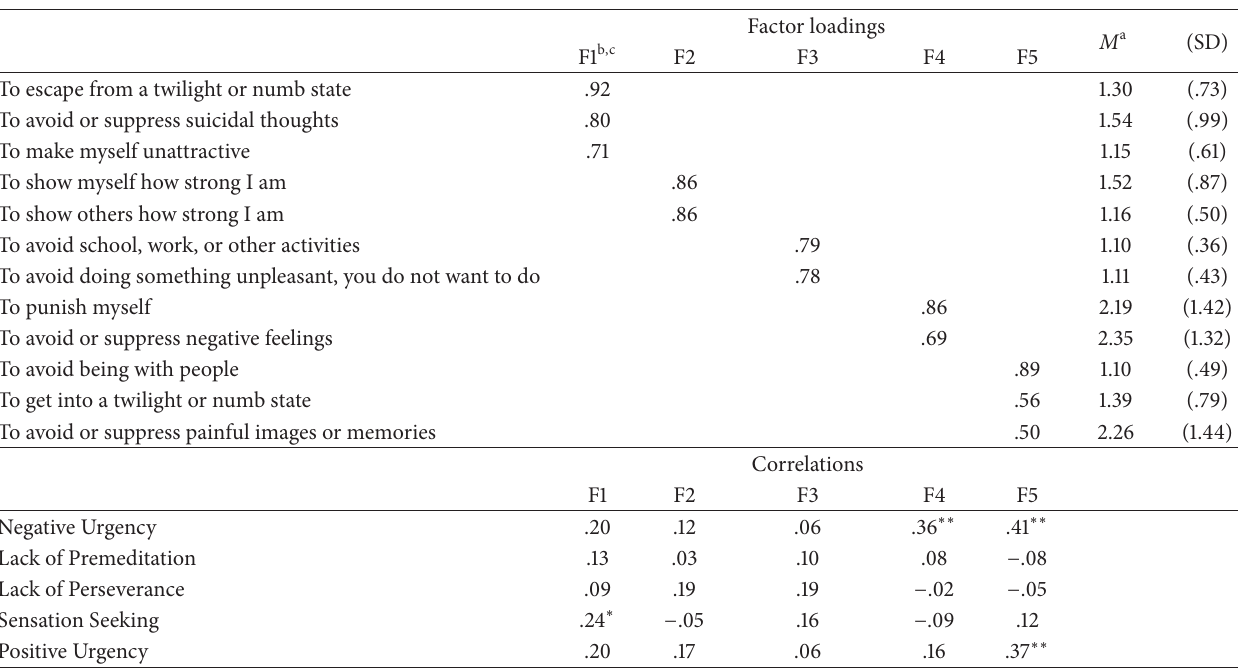
Table 2: The factor loadings, means, and standard deviations of the NSSI functions, and the relationship between the NSSI function factors and the UPPS-P impulsivity